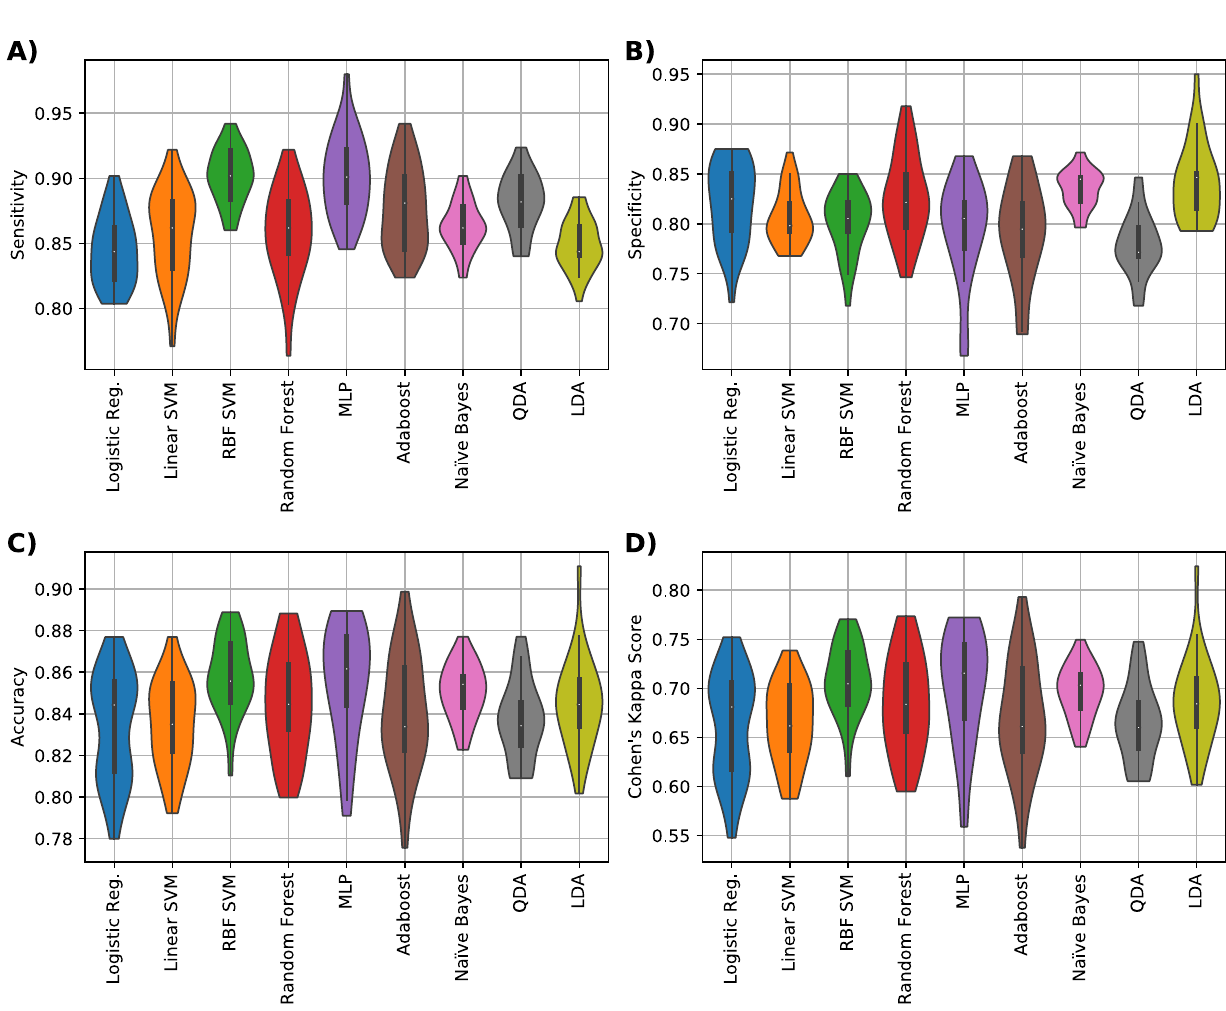
classification performances than the other learners. Notably, the RBF-SVM learner that showed to have higher classification performance than the other learners, also showed to have competitive running time (18.1048 s). Identification of the proteins found to correspond to the MALDI‑TOF spectral peaks recognised as discriminant by the trained classifiers. The ten peaks identified as providing optimal discrimination between two classes were further analysed to identify their cognate S. uberis proteins. Both MALDI-TOF spec- tral feature methods share the same 10 statistical different peaks, with the difference being that on the binning